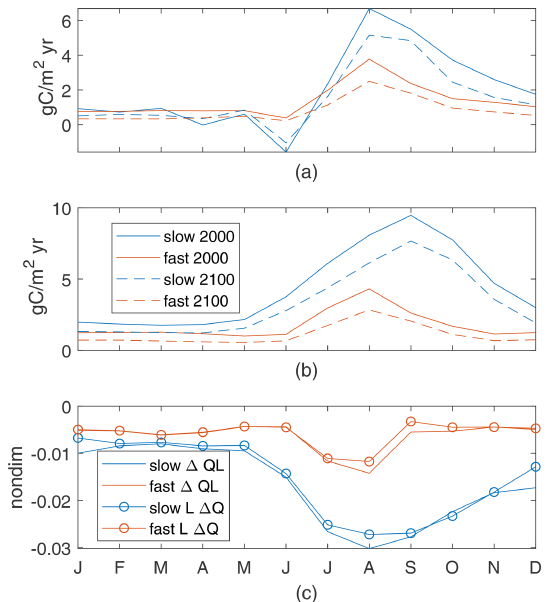
Figure 8. Subtropical South Pacific nutrient supply (a) and pro- duction of particles (b) . Production controls (c) normalized by maxQL(2000) values in the region: 0.032 for the slow case and 0.013 for the fast